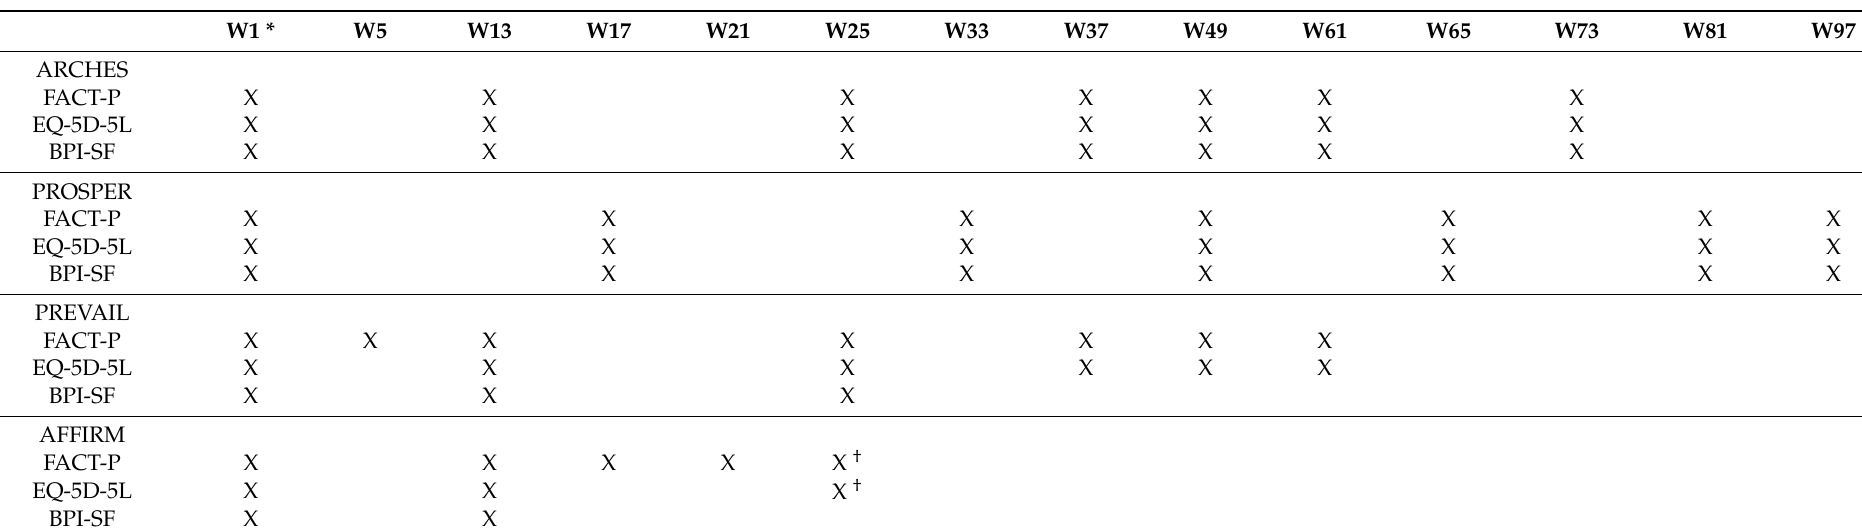
Table A1. Frequency of